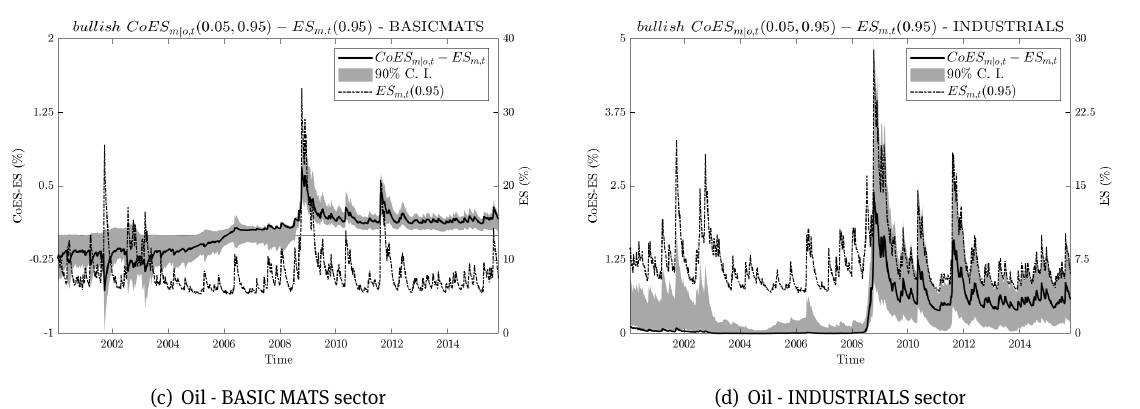
Left axis shows the difference in percentage between the CoES (0.05, 0.95) of the returns for a certain sector under a extreme m , t downward movement in oil prices, i.e. below its 5-th quantile, and its unconditional ES (0.95). Solid blue line shows this m , t difference given the best copula mixture according to Table 6. Grey area indicates the 90% confidence interval of the difference between CoES (0.05, 0.95) and ES (0.95) following a Monte Carlo technique explained in Appendix C. The right axes m , t m | o , t shows the value of the ES (0.95) in percentage. The dash-dotted black line indicate the ES level over m , t